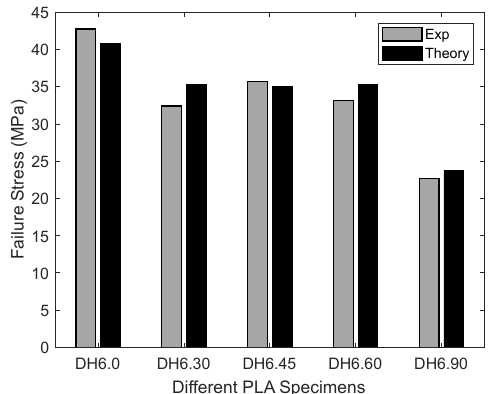
Figure 17. PLA failure stress for 6 mm drilled hole as a function of printing angle.